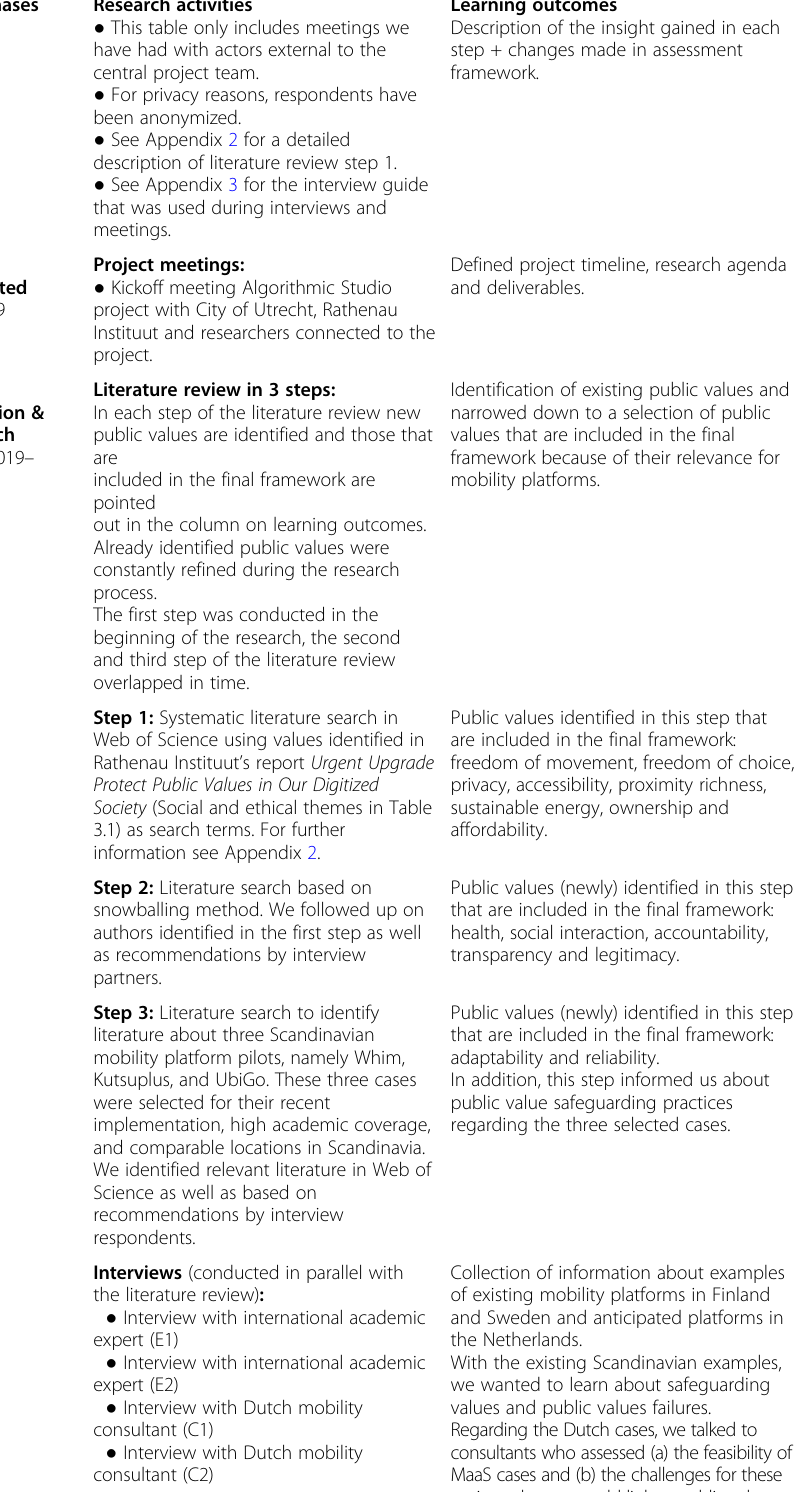
Table 4 Methodology: Overview of research activities and learning outcomes Research